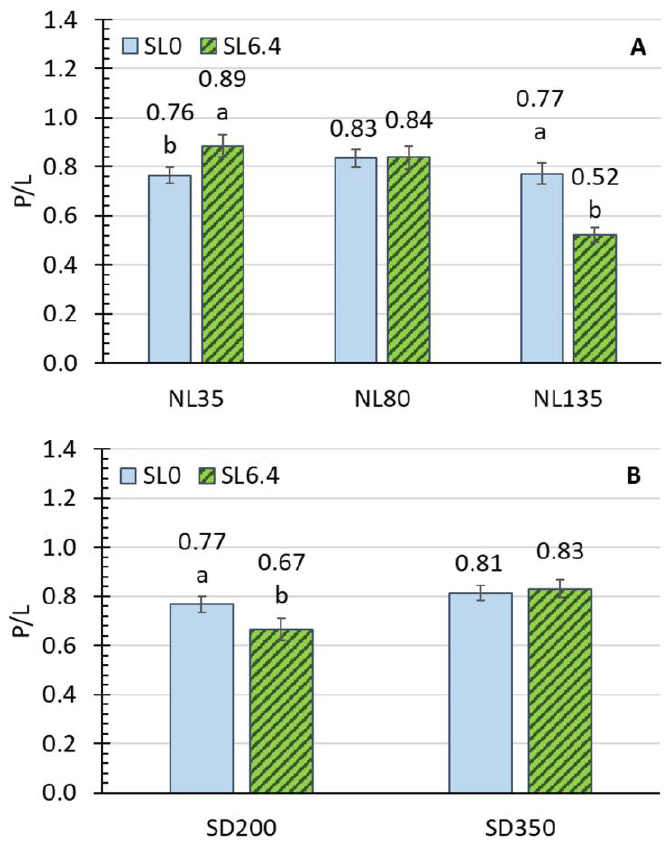
Figure 4. ( A ) Effect of nitrogen fertilization level (NL) and sulfur fertilization level (SL) on the ratio between dough tenacity and dough extensibility (P/L). ( B ) Effect of seeding density level (SD) and sulfur fertilization level (SL) on the ratio between dough tenacity and dough extensibility (P/L). Lowercase letters represent the Tukey HSD post hoc test